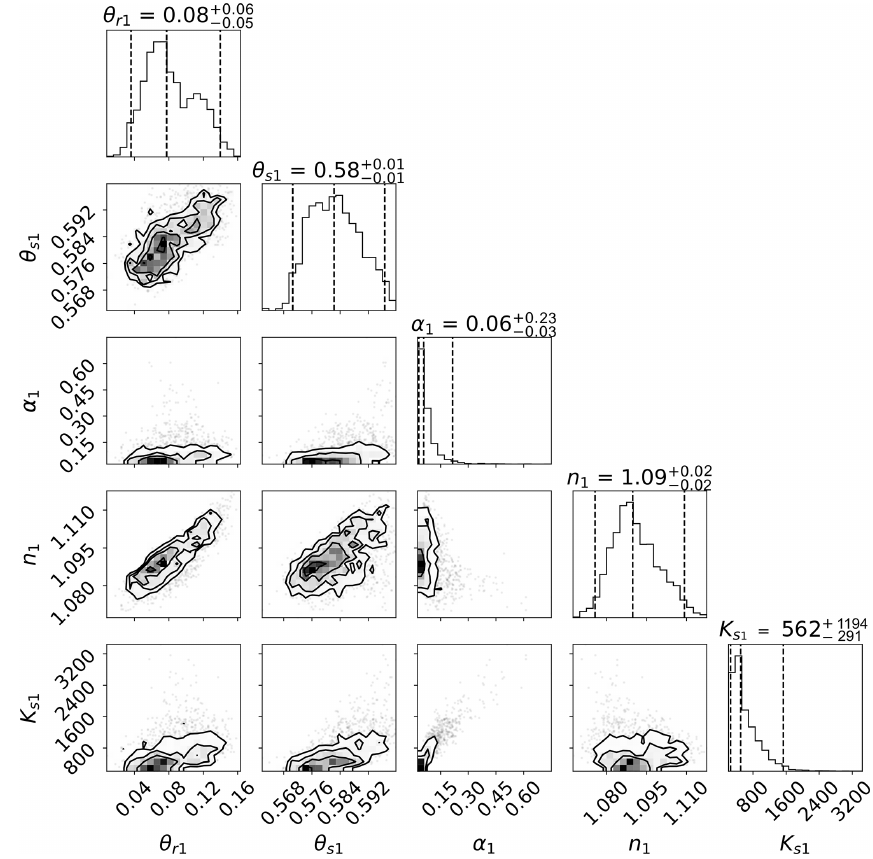
Figure A3. Marginal posterior distributions (one-dimensional projection on top of each column and the joint distributions of each two param- eters below) of estimated SHPs for the upper soil layer at Zettersfeld. Presented are the respective residual and saturated water content param- eters θ r and θ s (cm 3 cm − 3 ), the VGM shape parameters α (cm − 1 ) and n (–), and the saturated hydraulic conductivity parameter K s (cmd − 1